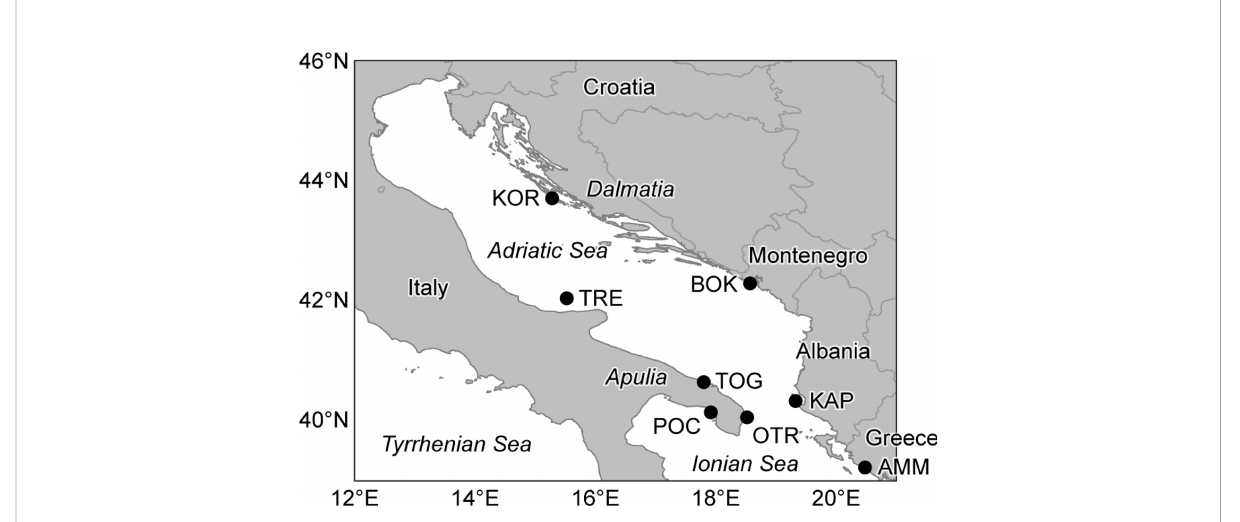
FIGURE 1 Sampling locations of Pachygrapsus marmoratus . See Table 1 for location